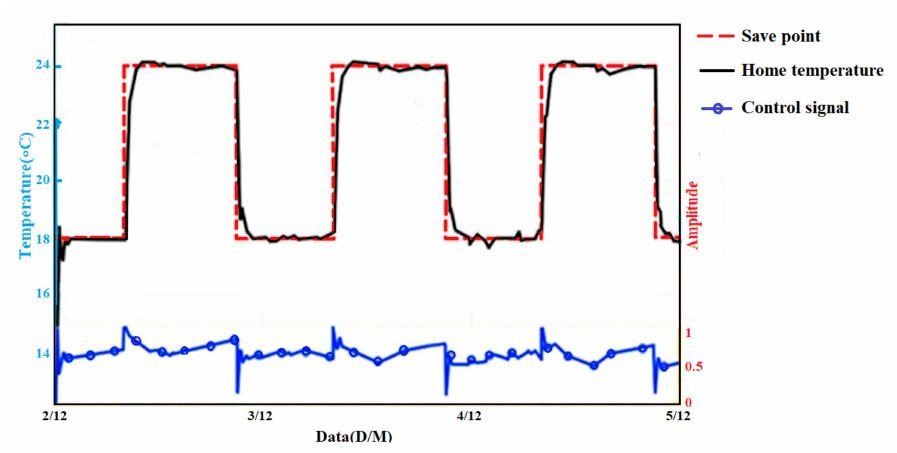
Figure 13. Room temperature change during simulation for the controller.